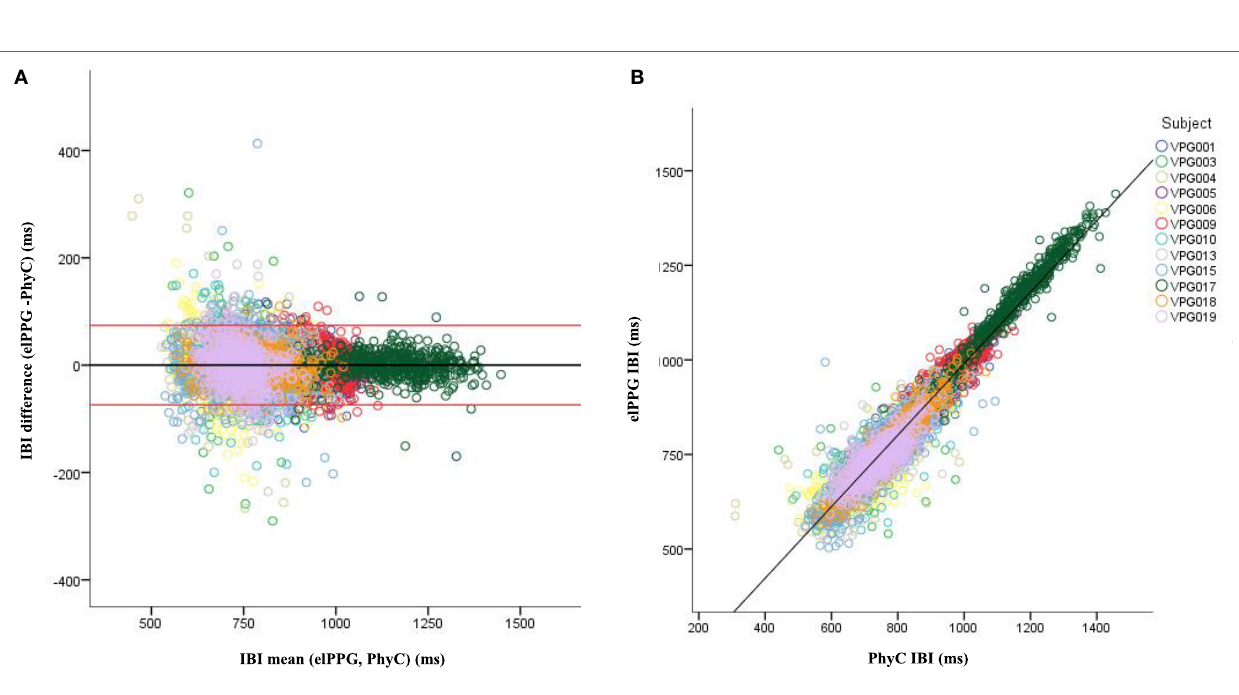
FigUre 4 | Bland–Altman and scatter plot for interbeat interval (IBI) from the elPPG and PhysioCam (PhyC), color coded by participant. (a) Plot of the IBI differences vs the means for the elPPG and PhyC. Red lines indicate the 95% confidence interval. (B) Scatter plot of the PhyC vs elPPG IBIs.